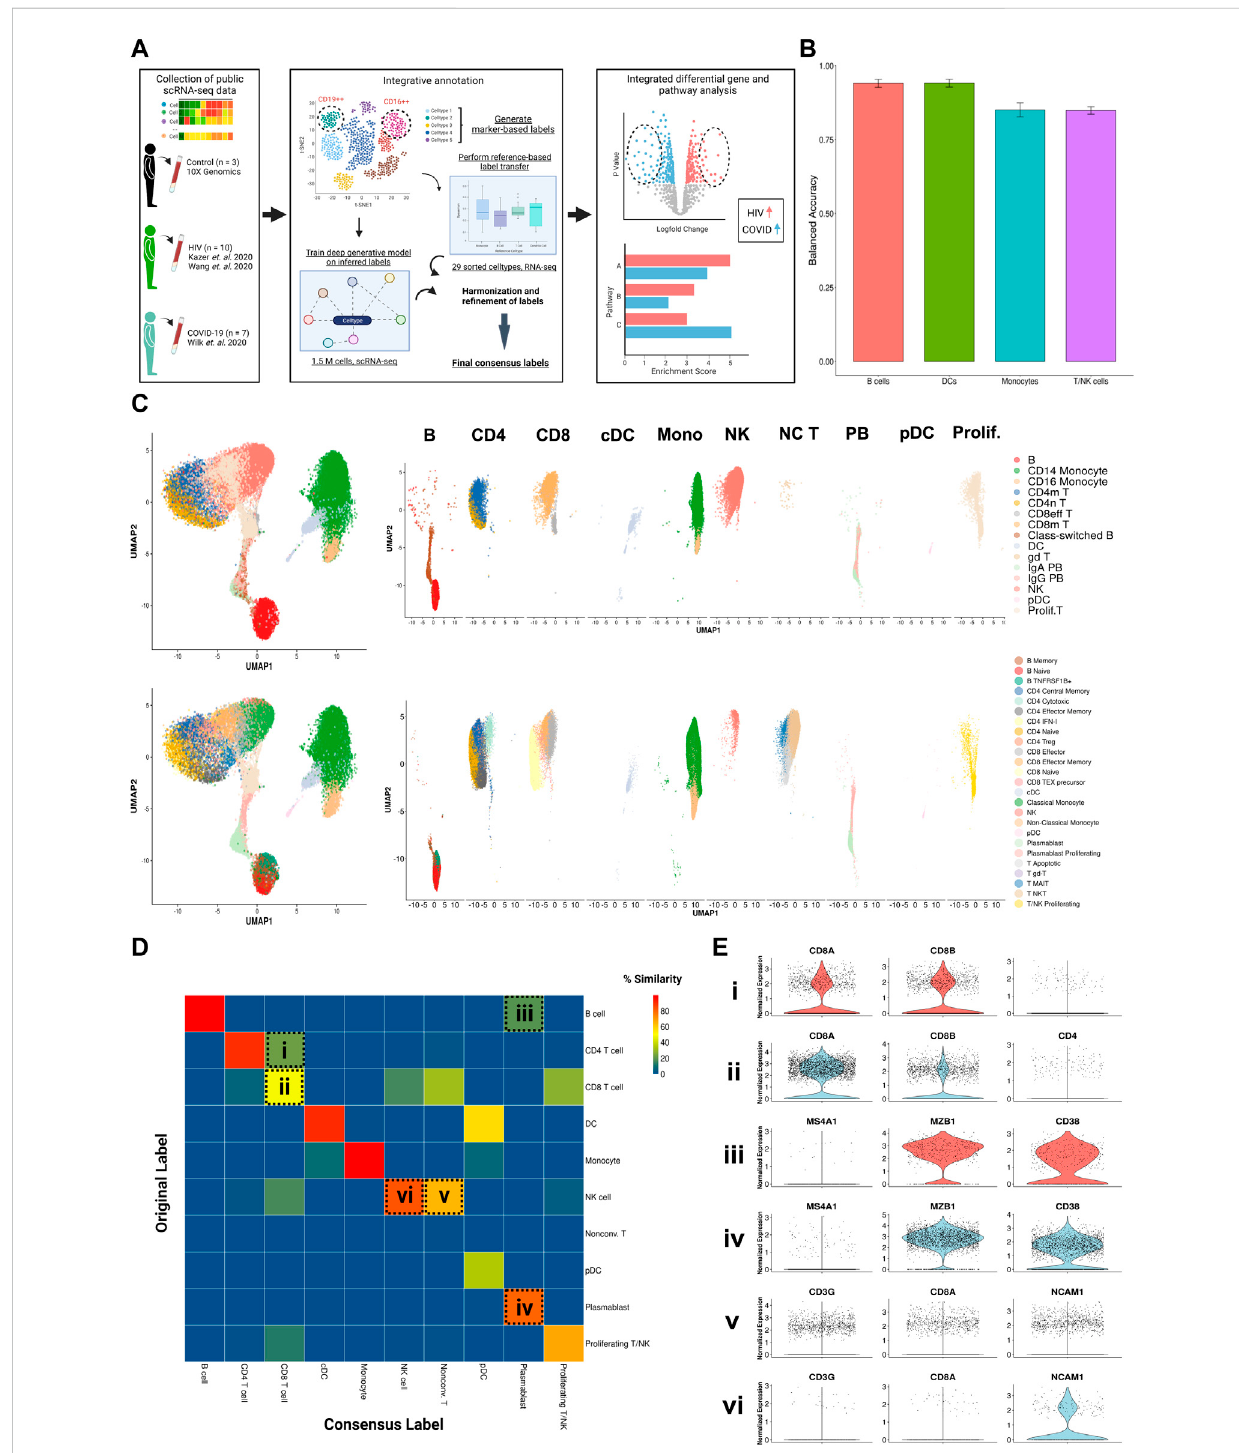
FIGURE 1 Consensus clustering method to annotate single cell transcriptomic data from multiple sources. (A) Illustrated work fl ow of data collection, consensus annotation, and downstream analysis. (B) Balanced accuracy of trained scANVI model on cell labels derived from Ren Cell 2021. Error bars denote variation of accuracy across labels within major cell categories. (C) Left: Uniform manifold approximation and projection (UMAP) embeddings of the integrated datasets colored by original (top) and consensus labels (bottom). Right: UMAP embeddings split by major cell categories colored by original (top) and consensus labels (bottom) illustrating the contrast in cell proportions using consensus method. (D) Confusion matrix illustrating percentageoverlap oforiginallabelsandconsensuslabelsacrossmajor cell categories. Percentageoverlap wascalculatedbydividing eachcellcount by the total number of cells in each column. (E) Violin plots of canonical normalized gene expression of designated cell populations indicated in 1D